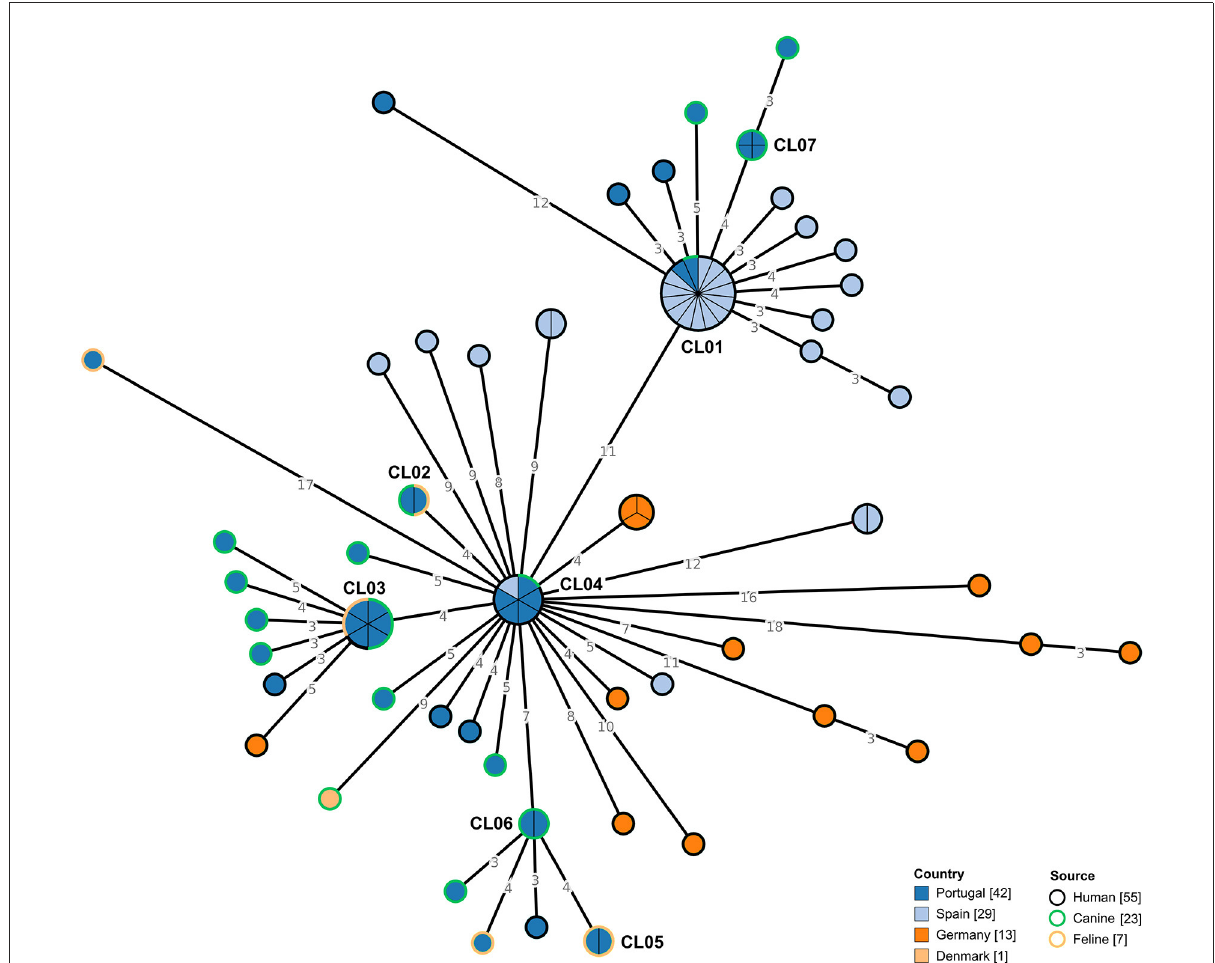
FIGURE3 Phylogeny of Clostridioides difficile isolates from ribotype 106 used in the present study. The minimum spanning tree (MST) was constructed based on the core-SNP diversity found among 85 isolates, relative to reference genome DH/NAP11/106/ST-42 (CP022524.1). All nodes (which represent a unique allelic profile) presenting an SNP distance ≤ 2, representing clusters with potential epidemiological relevance, have been collapsed for visualization purposes. Nodes are colored according to different countries of origin and their contour colored by respective source. The MST was generated using GrapeTree v1.5.0 software